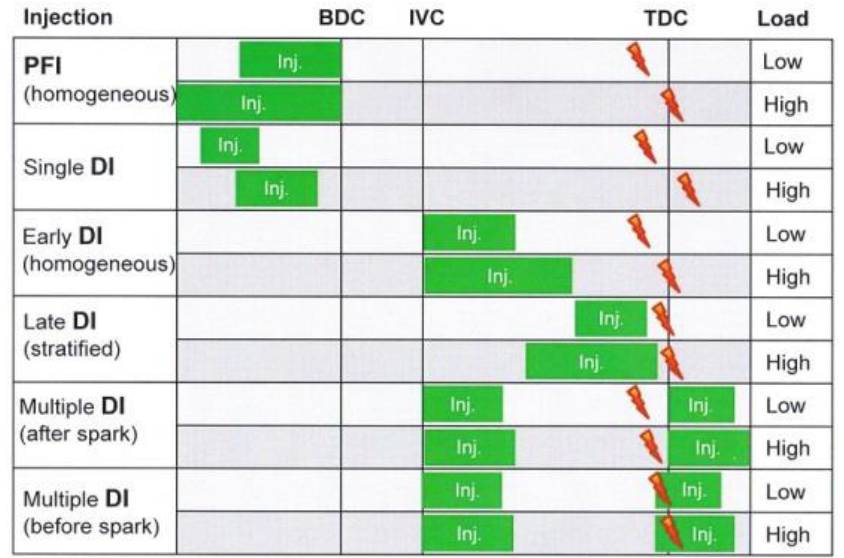
Figure 2. Comparison of various injection and ignition strategies Figure 2 Comparison of various injection and ignition strategies [99, 104] .